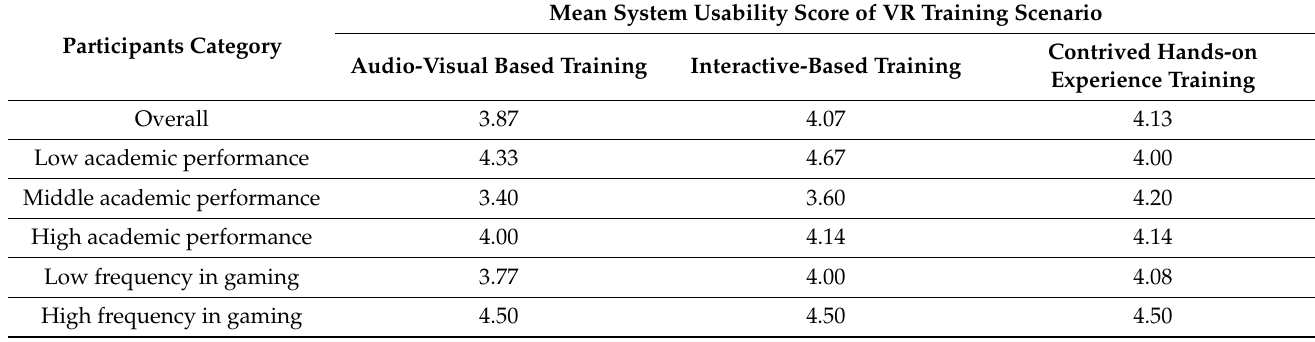
Table 3. Comparison of the quiz completion time between the developed VR training scenarios.